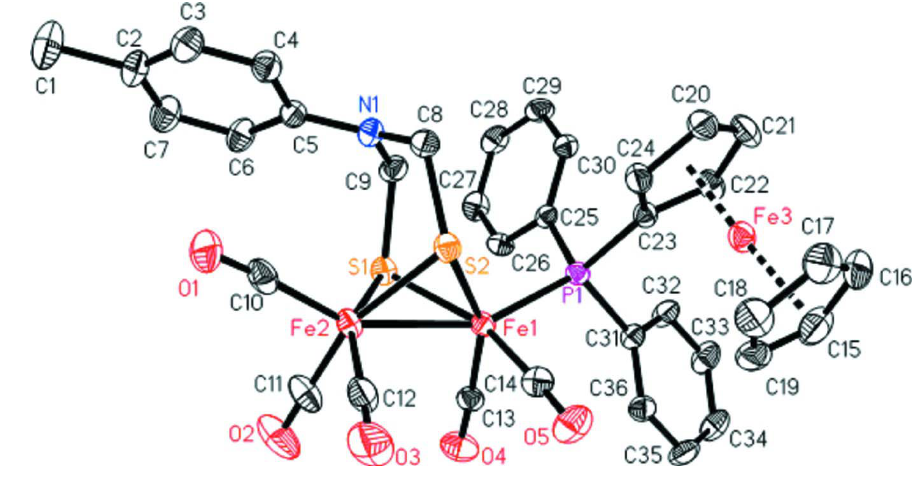
Figure 1 The molecular structure of the title complex, with displacement ellipsoids drawn at the 30% probability level. Pentacarbonyl-1 κ 2 C,2 κ 3 C-(ferrocenyldiphenylphosphine-1 κ P)[ µ -2-(4-